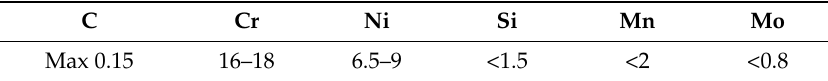
Table 1. Chemical composition of AISI 301 grade (in wt %) with balanced